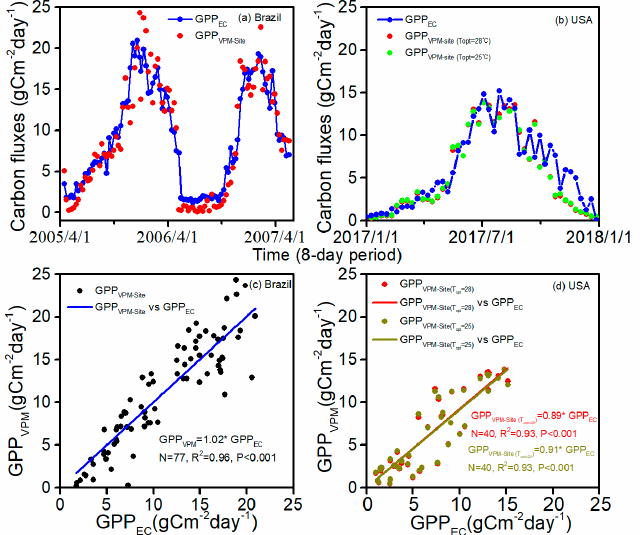
Figure 7. The seasonal variation in the estimated gross primary production (GPP EC ) and predicted gross primary production (GPP VPM-Site ) at the two sugarcane EC tower sites. ( a ) and ( c ), Brazil site, 2005–2007; ( b ) and ( d ), Louisiana, USA site, 2017. Table 1. A summary of the estimated gross primary production (GPP EC ) and predicted GPP VPM-Site at the sugarcane EC tower sites in Brazil and USA during the growing season defined by GPP EC and LSWI, respectively. GPP EC represents the seasonal sum of the estimated GPP from the sugarcane EC flux tower sites; GPP VPM-Site represents the seasonal sum of the predicted GPP from the VPM model; a and b are the seasonal sum the GPP VPM-Site at the USA site when T opt =25 ℃ and T opt =28 ℃ , respectively. GPP%RE represents the relative error, calculated as [(GPP VPM-Site − GPP EC )/ GPP EC ] × 100.